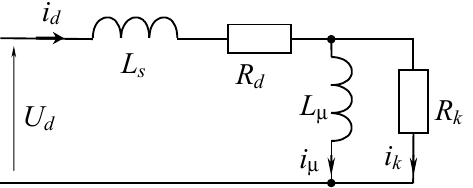
Figure 5. Traditional equivalent electric exciting circuits of a DC machine with eddy current element. i d is an exciting current; i µ is a magnetizing current; U d is an excitation voltage; i k is a current of fictitious element of eddy currents; L s is a leakage inductance for excitation winding; L µ is a magnetizing inductance for excitation winding; R d is a field resistance; R k is a resistance of fictitious element of eddy currents.